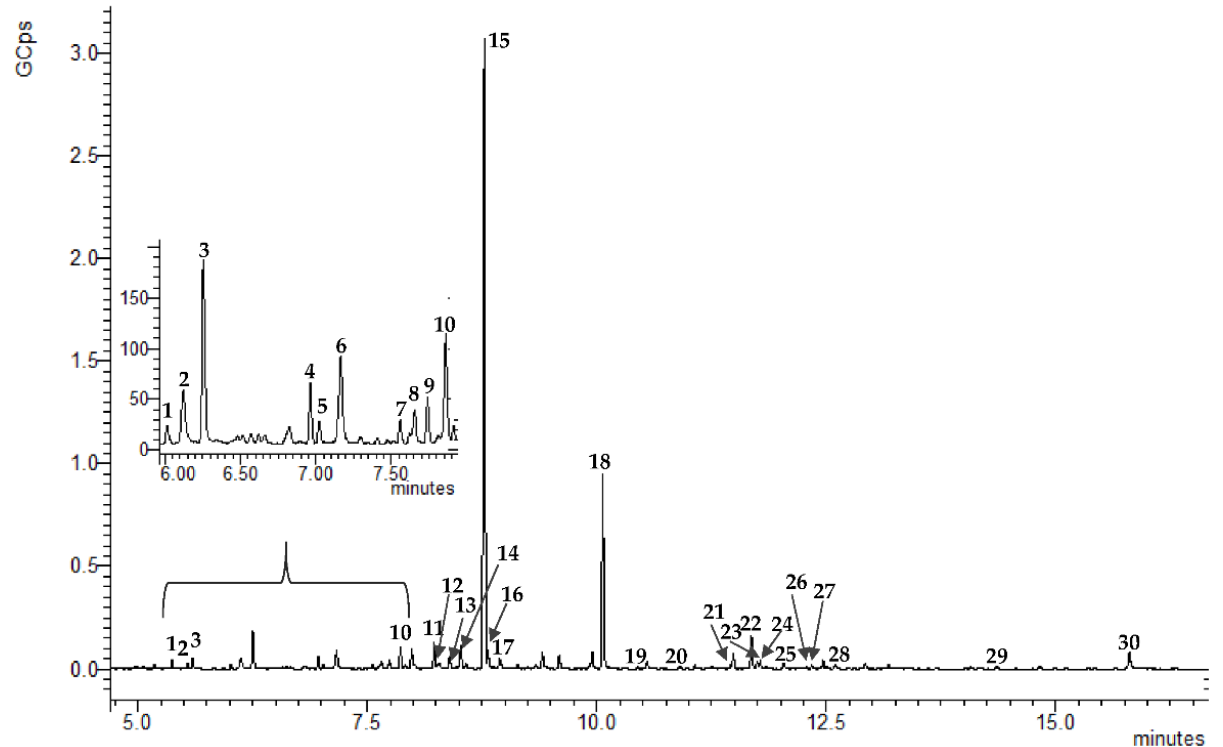
Figure 2. Chromatogram of Marrubium vulgare L. essential oil. Table 2. Chemical composition of essential oil of M. vulgare .